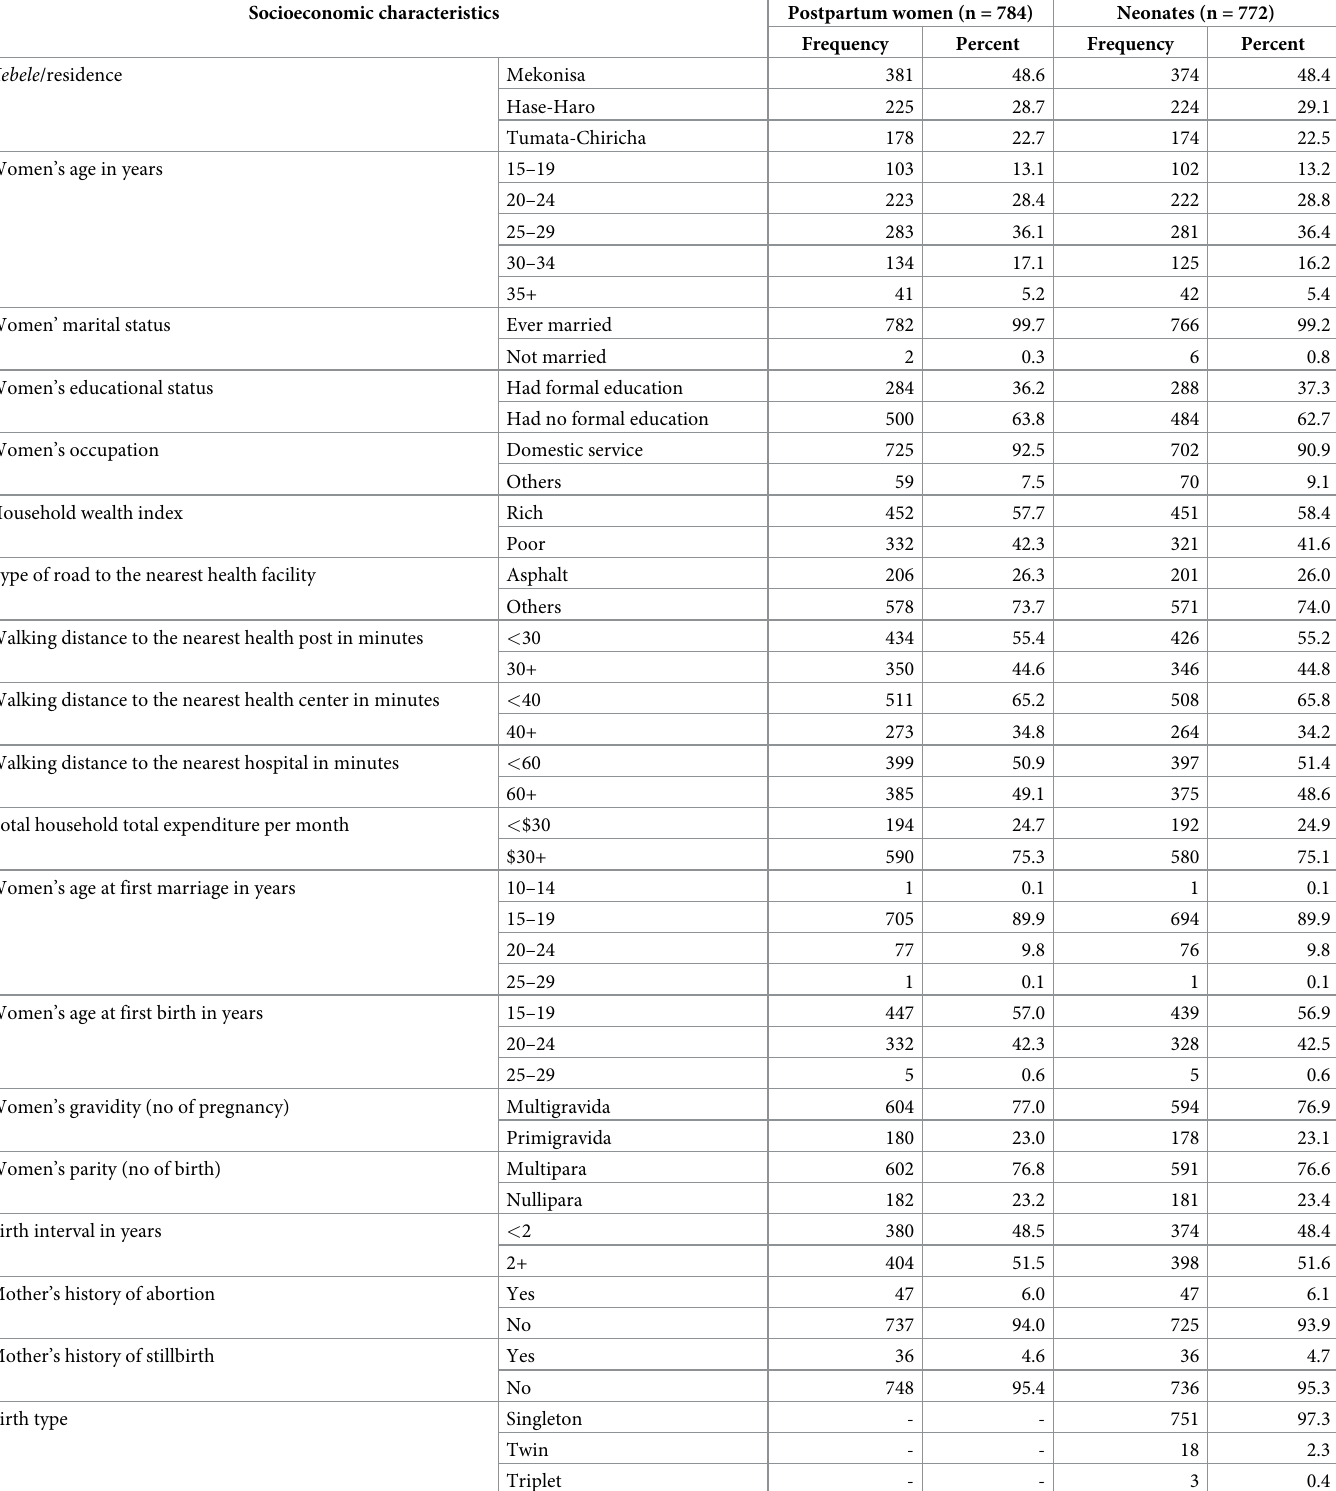
Table 1. Characteristics of study participants in rural southern Ethiopia, May 2017 to July